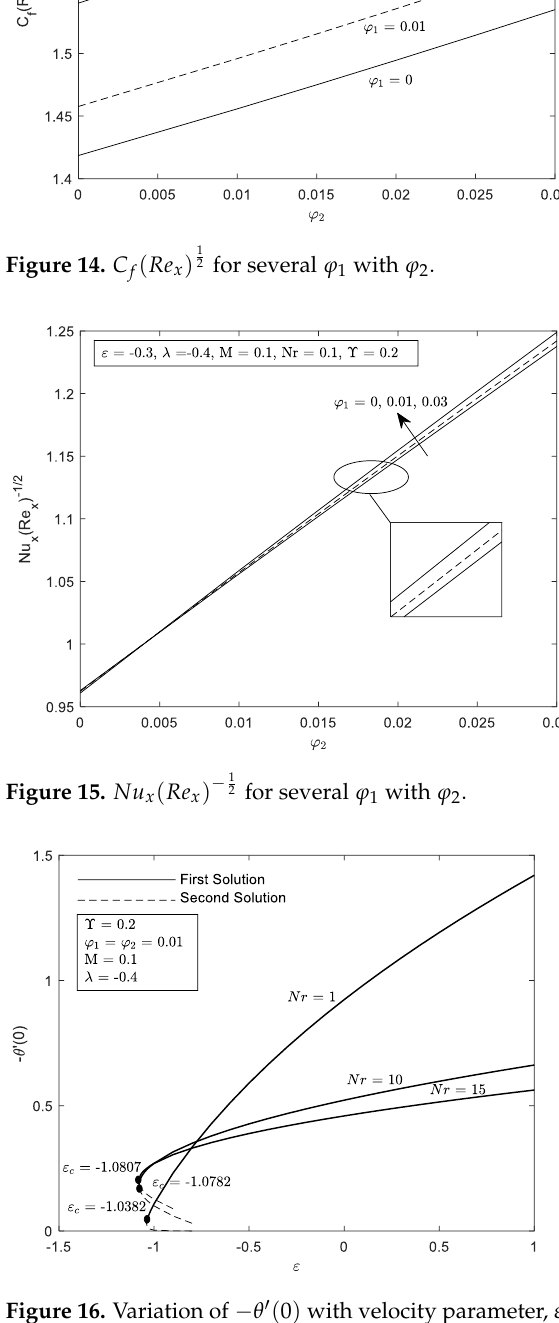
Figure 16. Variation of −𝜃 ′ (0) with velocity parameter, 𝜀 for several values of 𝑁𝑟.